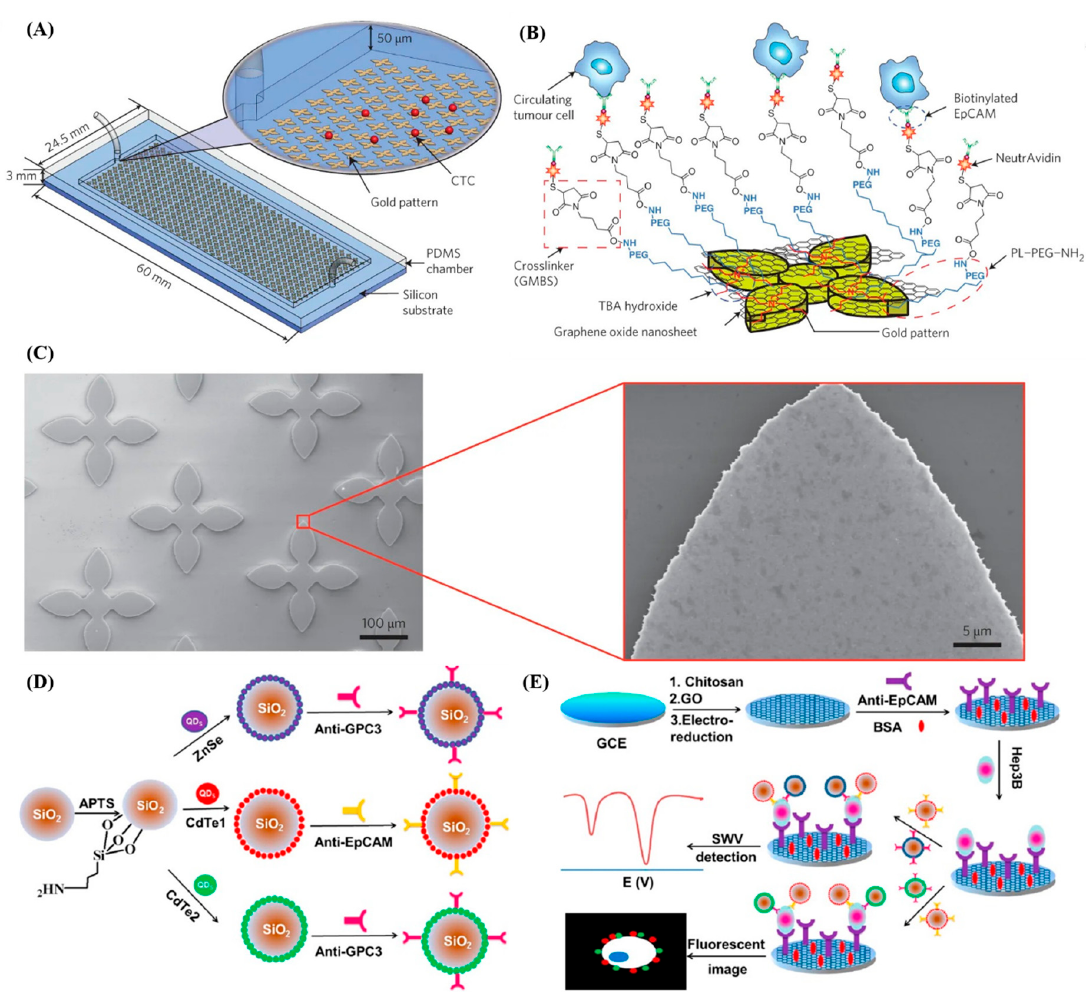
Figure 6. Application of nanomaterials to CTCs diagnostics. ( A ) Schematic of the GO chip. The silicon substrate has 58,957 flower-shaped gold patterns with dimensions of 100 μ m × 100 μ m. ( B ) Schematic showing the chemical conjugation between functionalized GO nanosheets and the EpCAM antibodies. GO nanosheets are adsorbed onto the gold pattern. The N- γ -maleimidobutyryloxy succinimide ester (GMBS) crosslinker binds to PL–PEG–NH2 on the GO nanosheets. The NeutrAvidin is connected to the GMBS and biotinylated EpCAM. (C) Left: Scanning electron microscope (SEM) images shows the gold patterns. Right: magnified SEM image shows adsorbed GO nanosheets on gold patterns [82]. ( D ) Schematic of the preparation of Si/Zn/anti-GPC3, Si/Cd1/anti-EpCAM, and Si/Cd2/anti-GPC. ( E ) Ultrasensitive graphene-enhanced fluorescent and electrochemical CTC detection procedures [84].